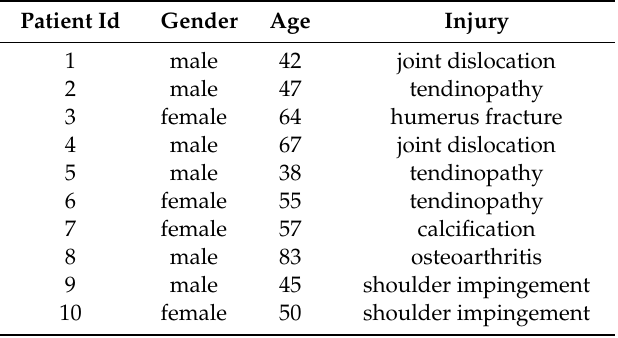
Table 1. Patient´s